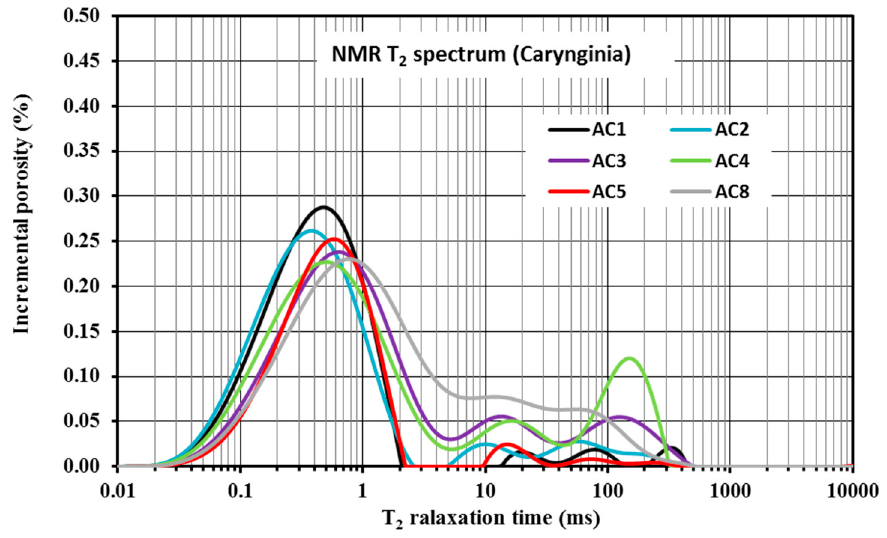
Figure 3. NMR T 2 spectrum for Carynginia shales (i.e., AC1-AC8).